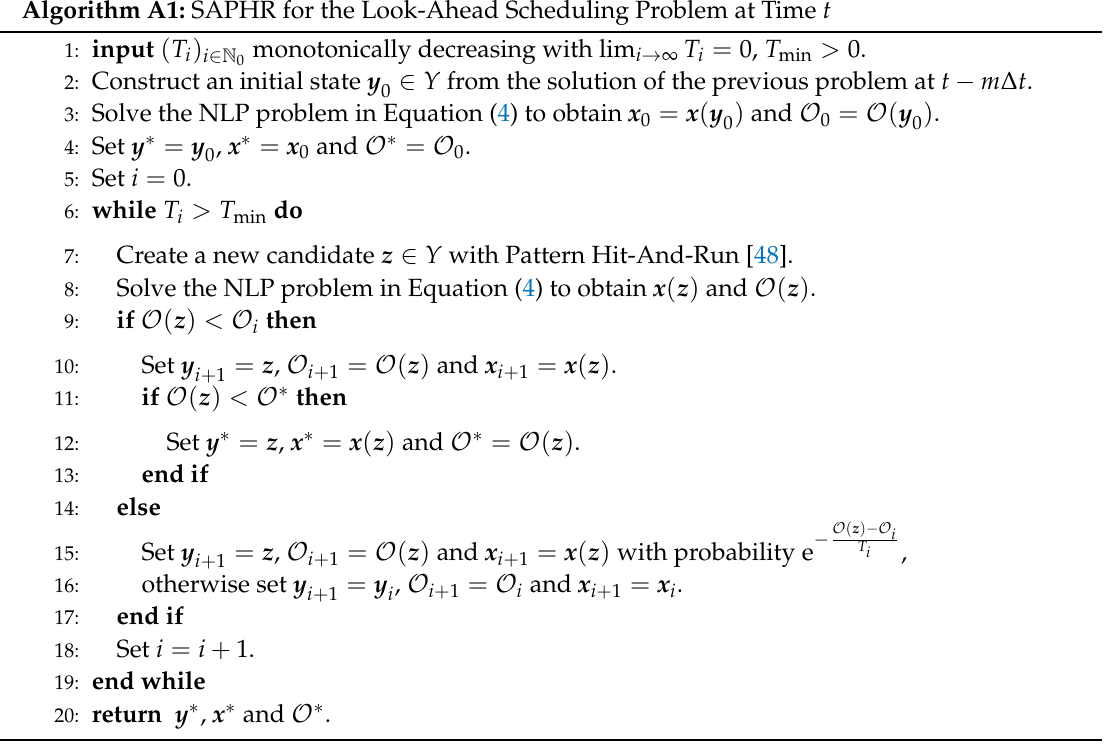
Algorithm A1: SAPHR for the Look-Ahead Scheduling Problem at Time